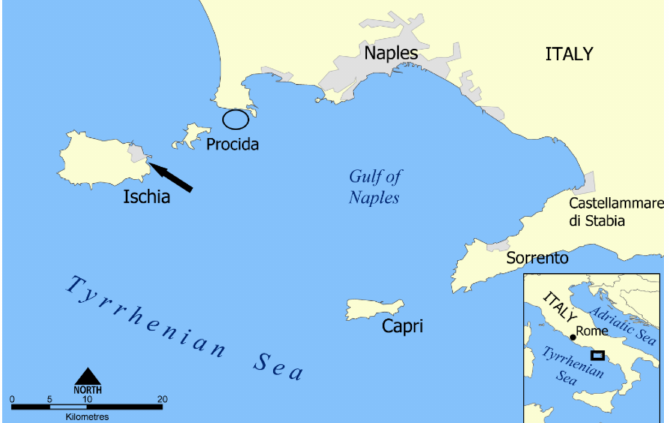
Figure 1. Sampling area in the gulf of Naples, Italy. The small circle indicates the sampling area for P. lividus off the mainland. The black arrow indicates the sampling station in the harbor of Ischia